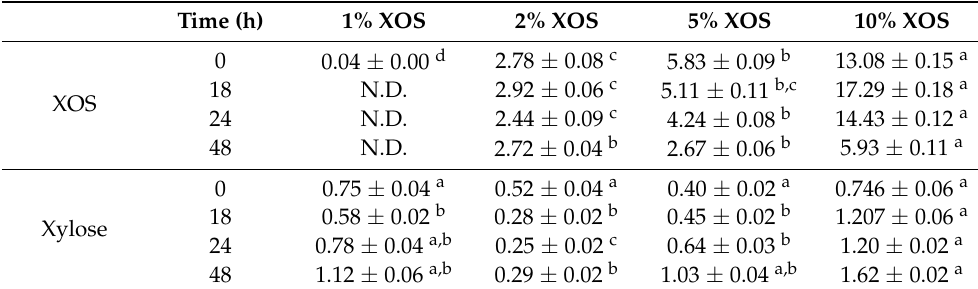
Table 3. Quantity of xylose and XOS (mg/L) during fermentation. Time